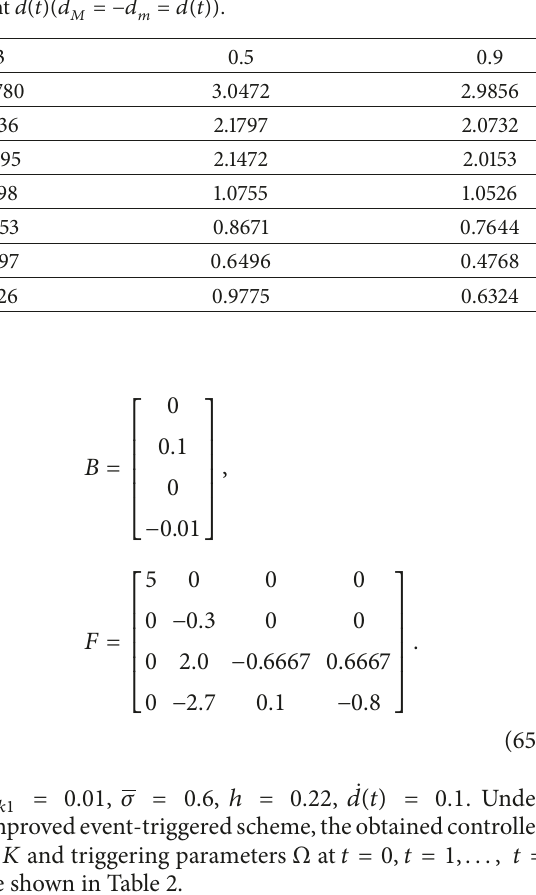
̇𝑑(𝑡)(𝑑 = −𝑑 = ̇𝑑(𝑡)) 𝑀 𝑚